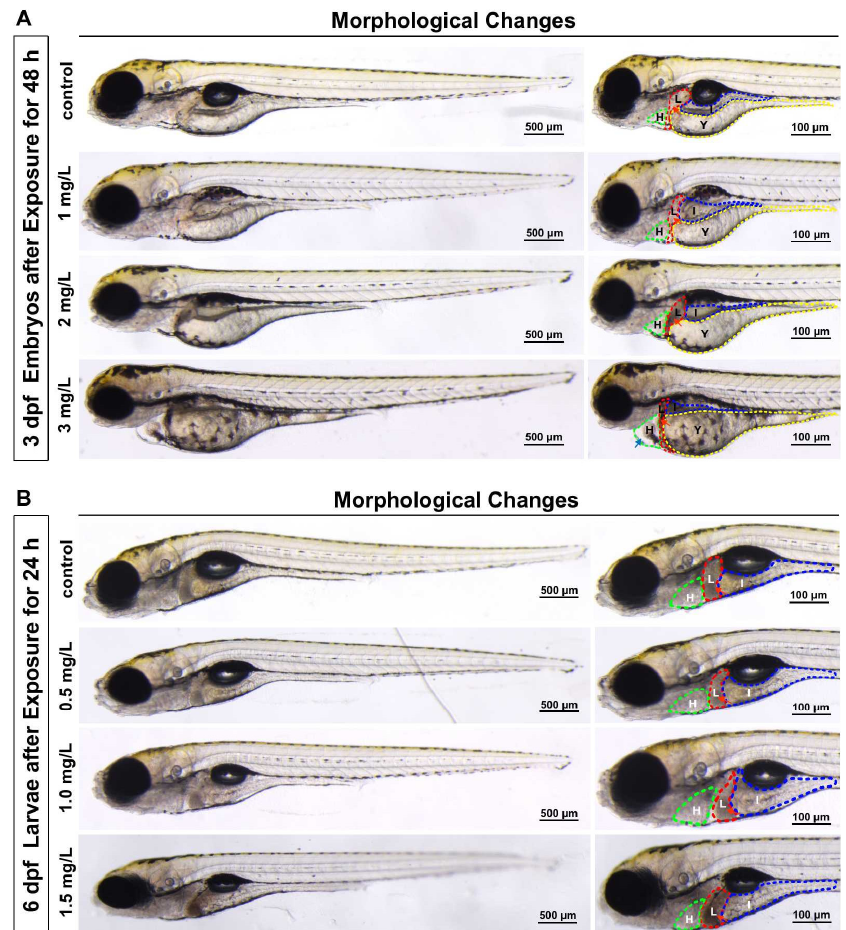
Figure 2. Effects of development after triflumizole exposure in zebrafish. ( A ) 3 dpf zebrafish embryos with morphological changes after triflumizole exposure for 48 h. ( B ) 6 dpf zebrafish larvae with liver degeneration after triflumizole exposure for 24 h. Blue arrows and red arrows indicate pericardial edema and liver degeneration, respectively. H: heart, the green dotted line; L: liver, the red dotted line; I: intestine, the blue dotted line; Y: yolk sac, the yellow dotted line. Scale bars = 500 µ m; Scale bars = 100 μ m.